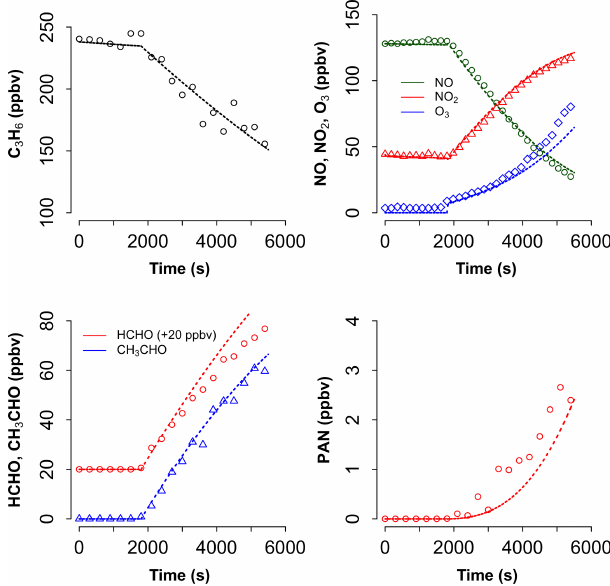
Figure 6. Measured (points) and modelled (lines) mixing ratios of propene (C 3 H 6 ), ozone (O 3 ), nitrogen oxides (NO, NO 2 ) and propene oxidation products (HCHO, CH 3 CHO, PAN) during a propene oxidation experiment at the CESAM atmospheric simula- tion